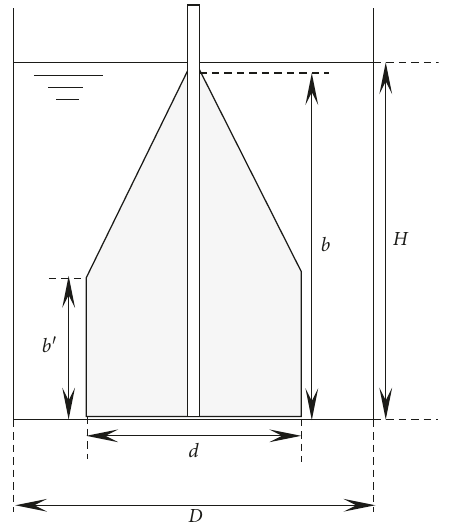
Figure 1: Schematic diagram of the HB-type impeller.